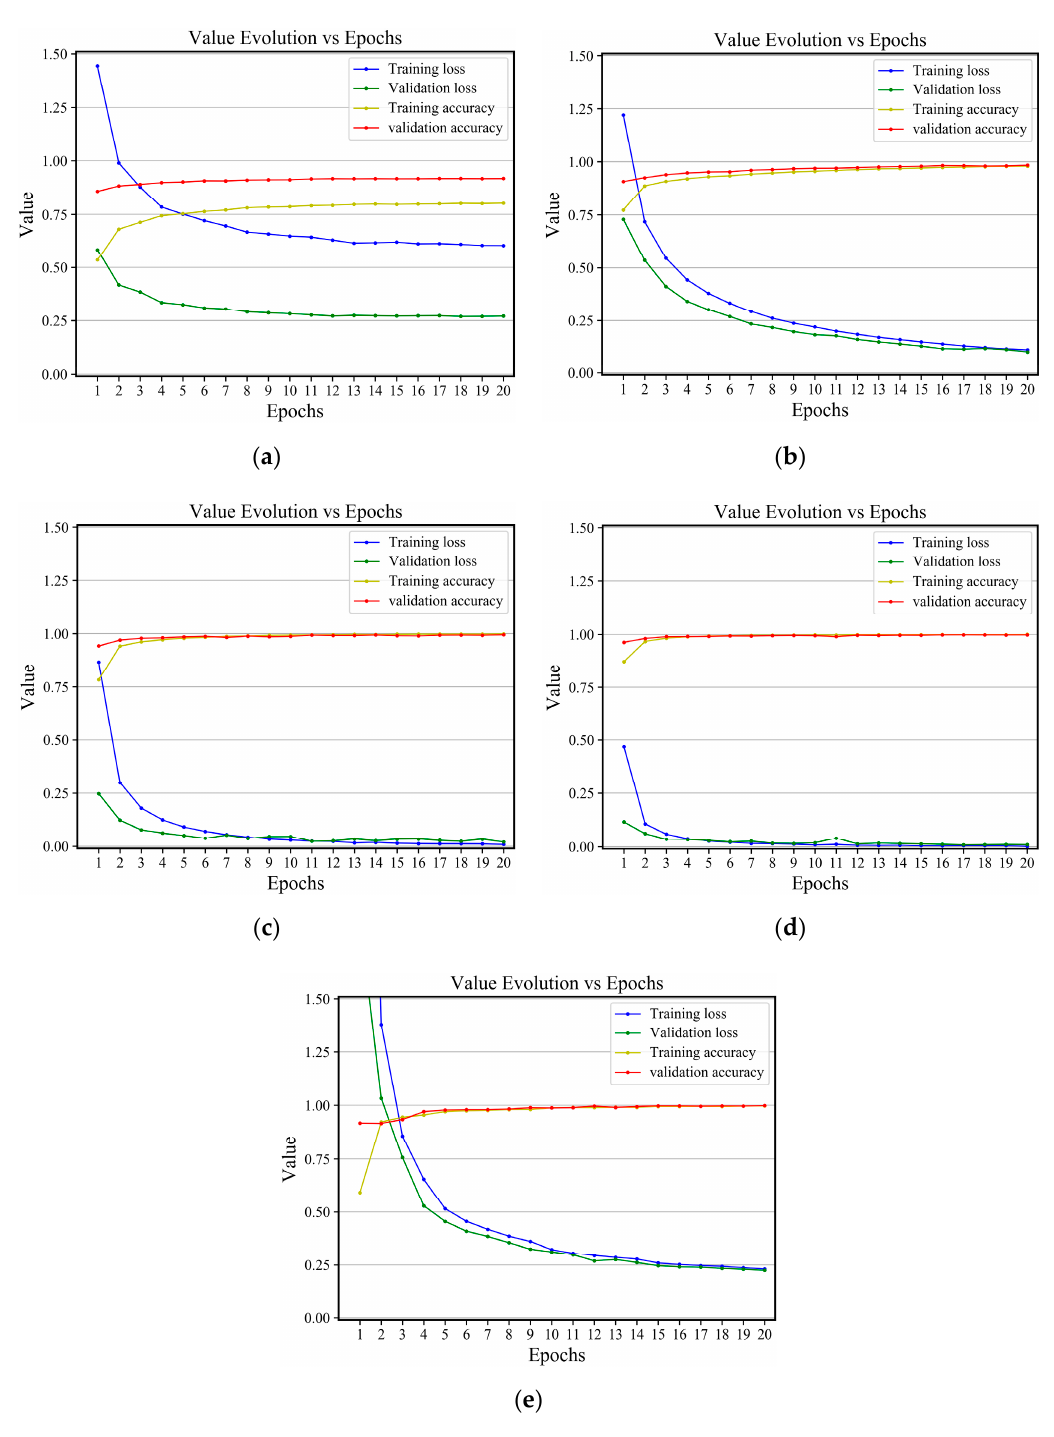
Figure 21. GF5AX dataset: Evolution of the accuracy or loss in terms of epochs on training and validation data. ( a ) SSLSTMs, ( b ) 3D CNN, ( c ) FDSSC, ( d ) SSRN, ( e ) SSCC.